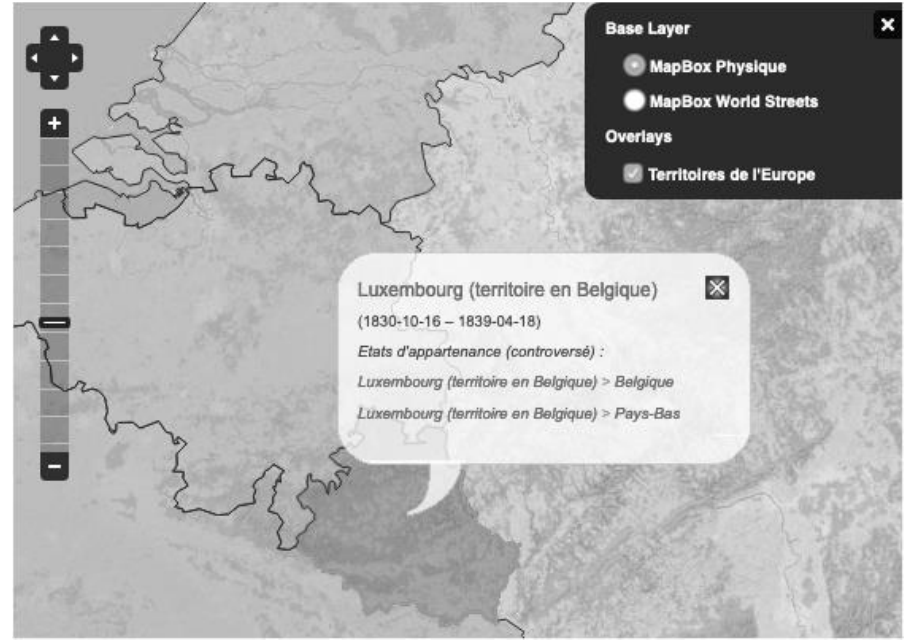
Figure 6. Luxembourg 1830 – 1839, as Represented in the Geo-Larhra System.